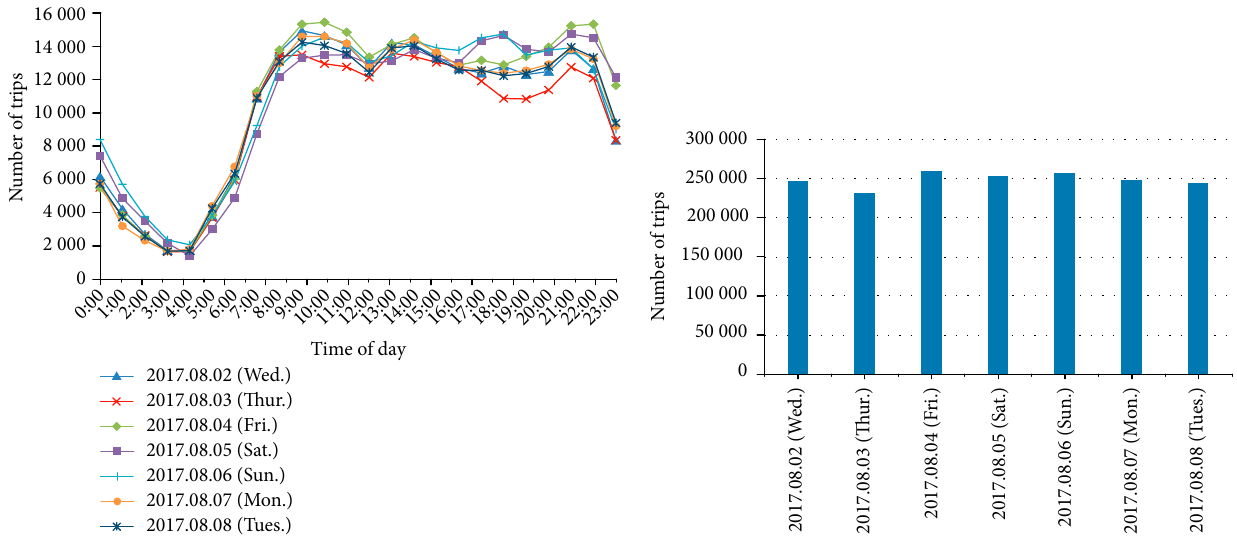
Figure 3: The distribution of number of trips for taxi in one week.